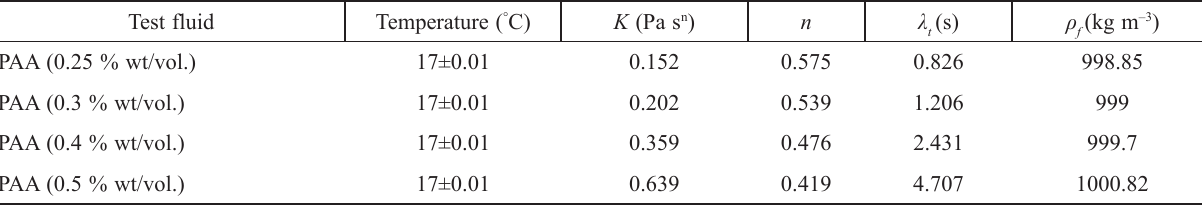
Fig. 2 – Observed pressure drop per unit length of coil (ΔP/ Fig. 2 Observed pressure drop per unit length of coil ( Δ P/L c ) versus Reynolds number (Re) for L ) versus Reynolds number (Re) for non-Newtonian c viscoelastic fluids flowing through helical non-Newtonian viscoelastic fluids flowing through helical coil (kg m –3 ) f